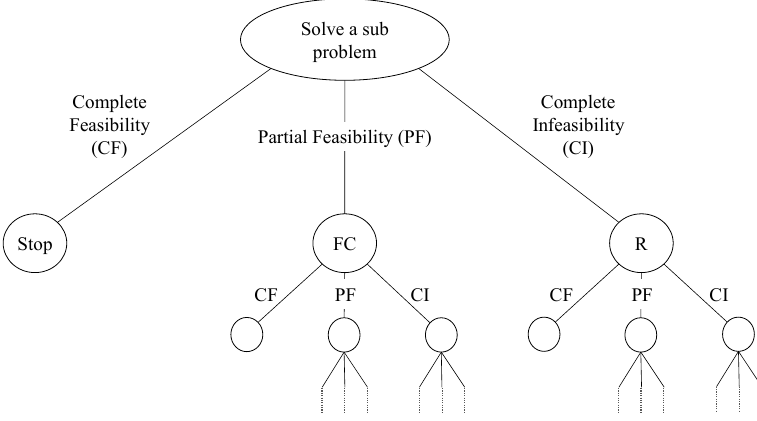
Figure 1. Conceptual view of the branch-and-freeze (BF) algorithm.